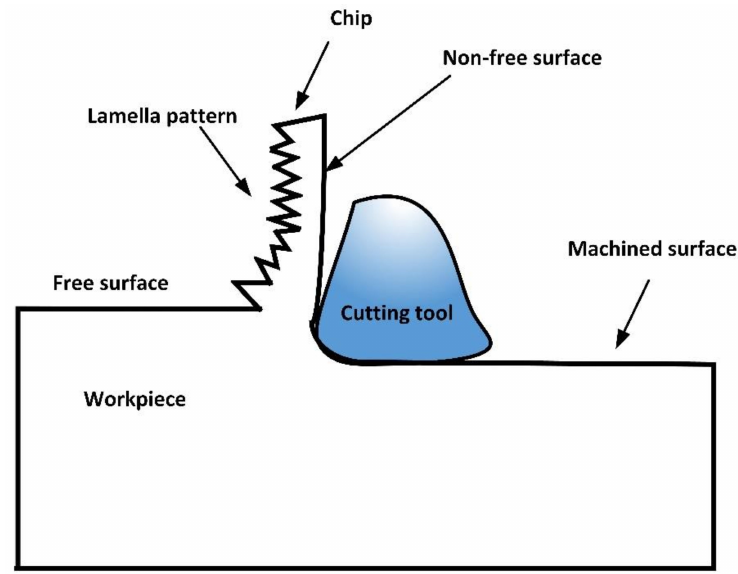
Figure 6. Schematic diagram of workpiece chip